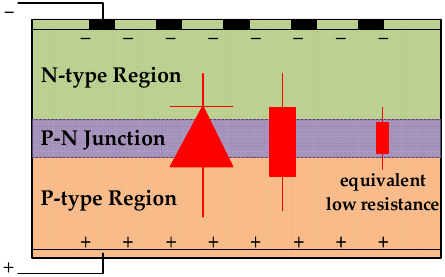
Figure 2. Equivalent model of battery unit in low resistance hot-spot area. The output I-U characteristics of the battery unit in the reverse bias state are shown in Figure 3, in which the blue dotted line represents the reverse characteristic curve of the low resistance hot-spot faulty unit, the red solid line represents the reverse characteristic curve of the normal battery unit, the grid area represents the corresponding heating power under a certain reverse voltage, and the green dotted line represents the reverse bias voltage. It can be seen from the Figure that the reverse output characteristics of normal battery units are similar to diodes. There will be a small reverse current under the action of reverse voltage, and the current basically remains unchanged within a certain voltage range, so its heating power is small. The reverse output characteristic of the low resistance hot-spot unit is similar to that of resistance, and the resistance value is small. The current is positively proportional to the reverse voltage. At this time, its heating power is large. From the area of the grid area in the figure, it is obvious that when the low resistance hot-spot fault battery unit is shaded by local shadow and reversely biased, its heating power is much higher than that of the normal module, and the high temperature generated will cause serious damage to the photovoltaic module. Therefore, it is necessary to suppress the “current loss” flowing through the low resistance hot-spot area.